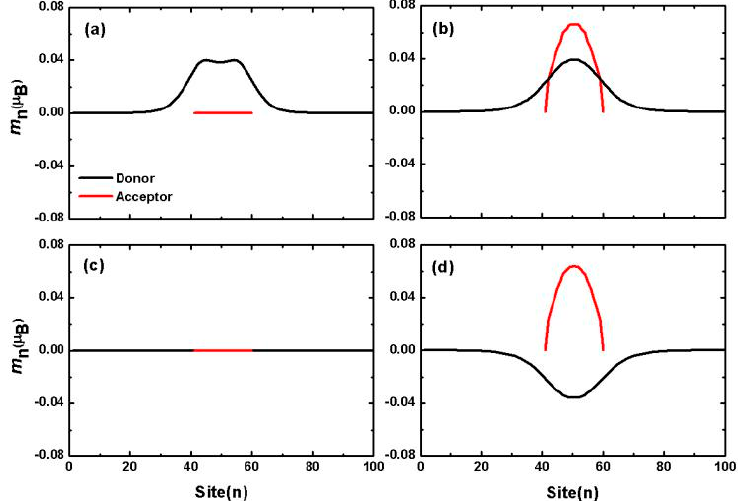
Figure 23. Intramolecular ( a , c ) and intermolecular ( b , d ) exciton spin density distribution. ( a , b ) For exciton EX1 and ( c , d ) for exciton EX2.